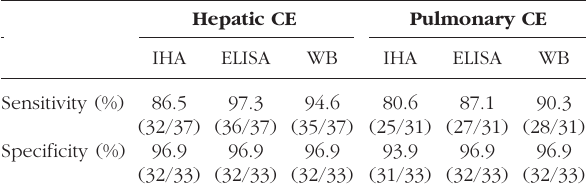
Table I. – The sensitivity and specificity of the tests performed for evaluation of hepatic and pulmonary